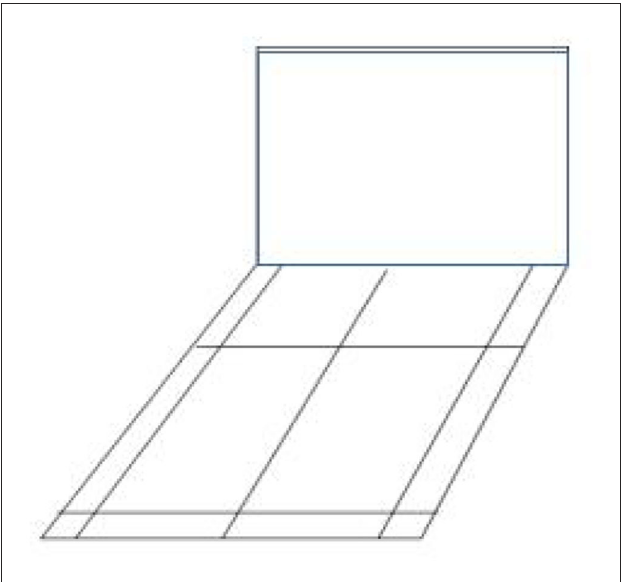
FIGURE1 A schematic diagram of the experimental test site